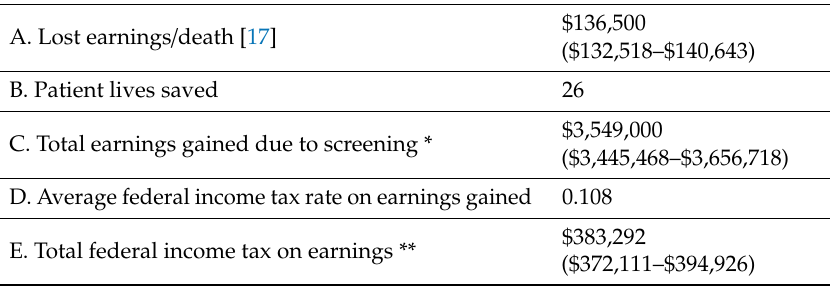
Table 5. Estimate of the lost earnings gained and federal income tax dollars recovered on those earnings due to screening.